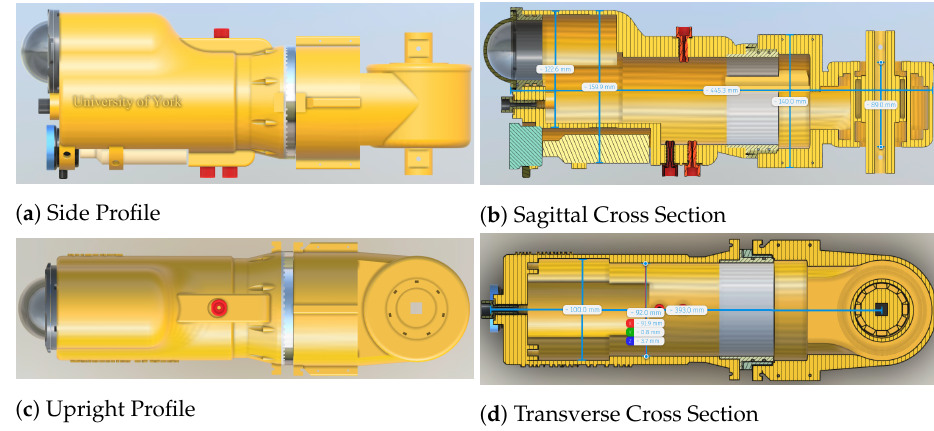
Figure 4. RoboFish Perspectives of the Head’s Cross